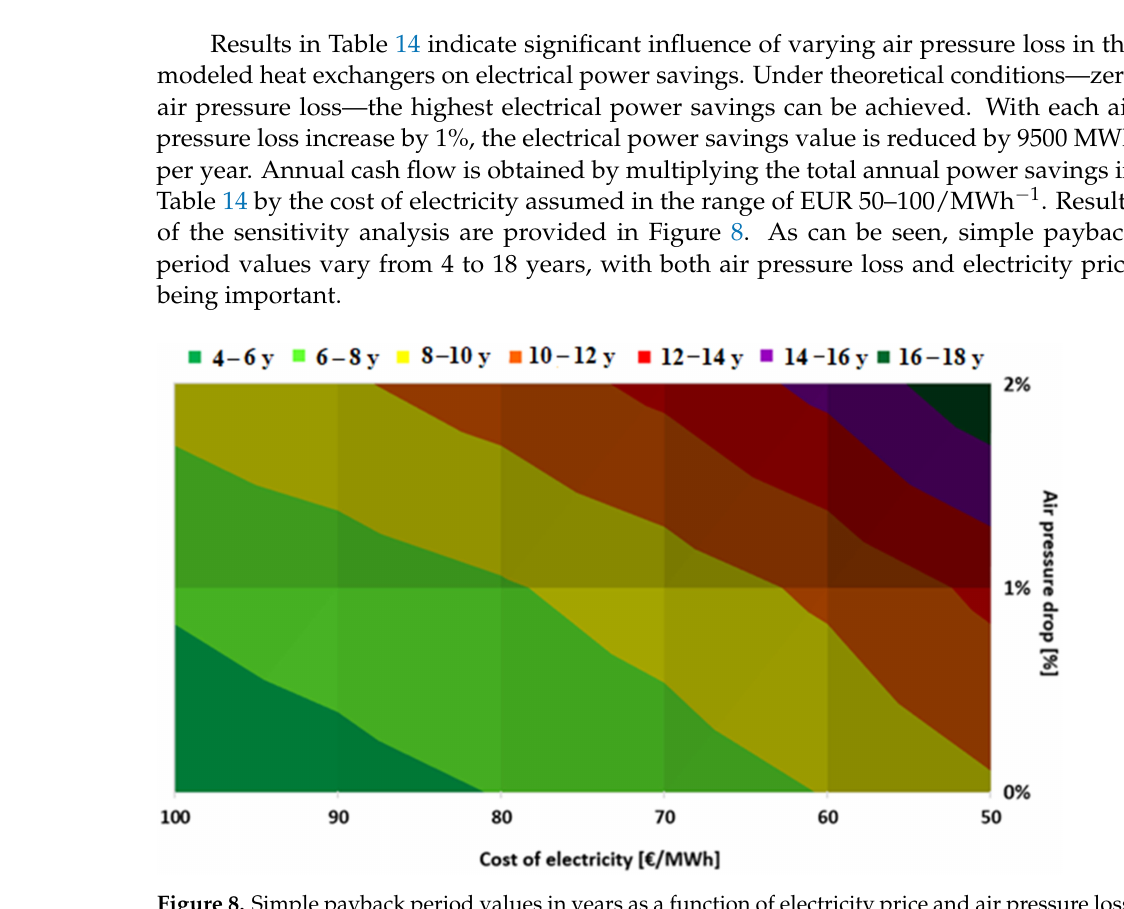
Figure 8. Simple payback period values in years as a function of electricity price and air pressure